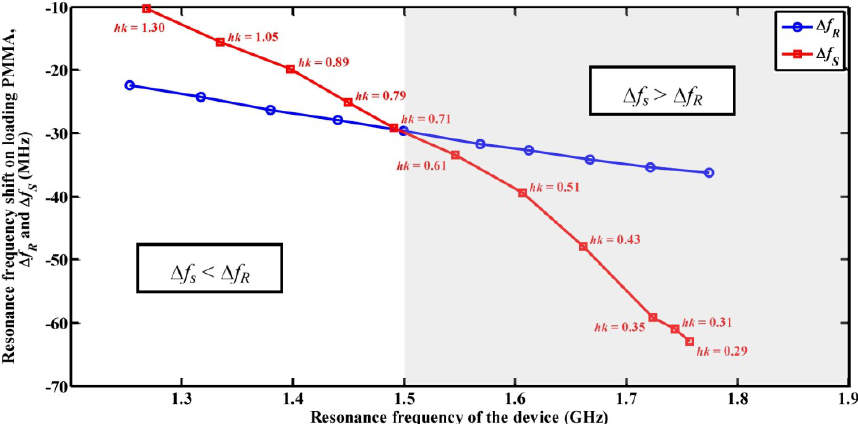
Figure 5. Plot of resonance frequency shift in Rayleigh and Sezawa wave mode ( Δ f versus device operating